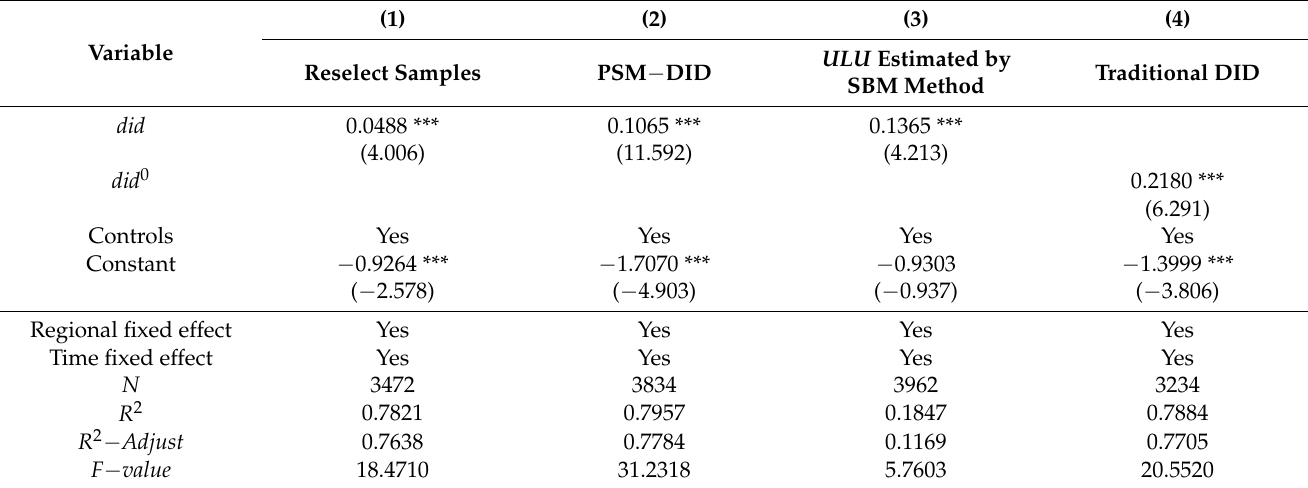
Table 6. Other robustness